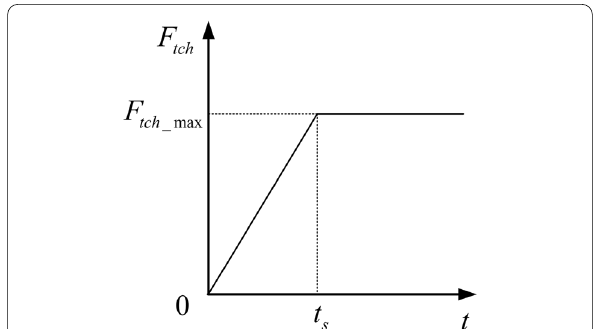
Figure 4 Variation trend of contact reaction force